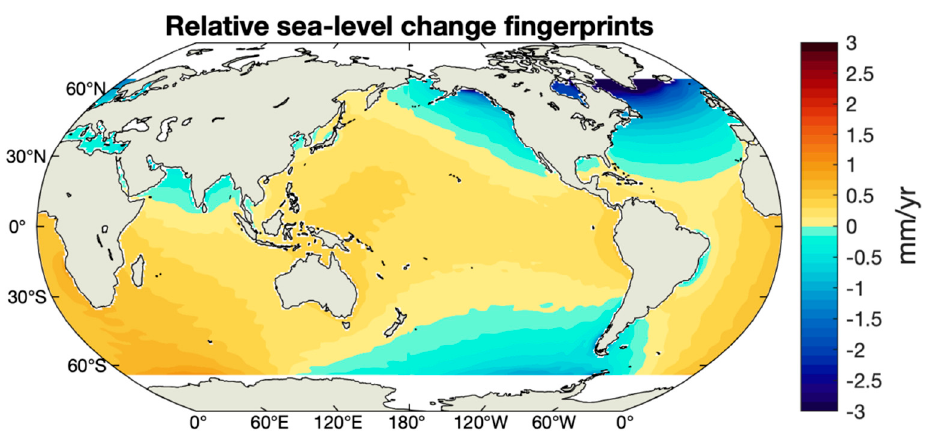
Figure 1. Linear spatial trends for absolute (top panel) and relative (bottom panel) sea-level finger- prints computed by [19] using GRACE CSR solutions for estimating land ice and terrestrial water mass changes, for the time interval from January 2005 to December 2015. Redrawn from [19].